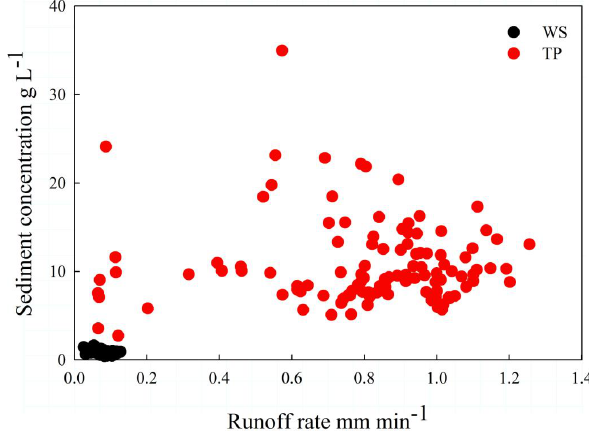
Figure 5. Runoff rates versus sediment concentrations for WS and TP management